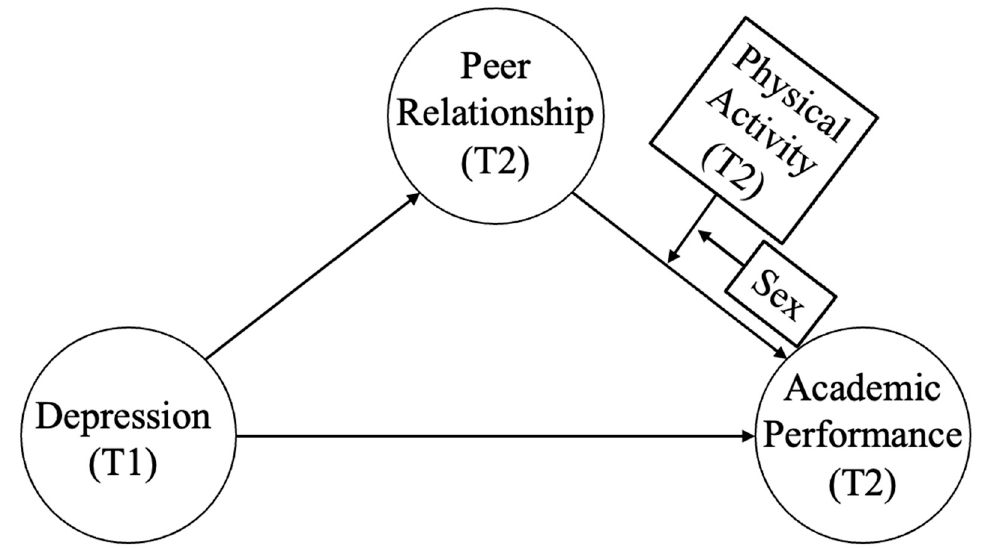
Figure 2. Moderated moderated-mediation model B (T1 represents time point 1, which represents the survey data in 2013; T2 represents time point 2, which represents the survey data in 2014).